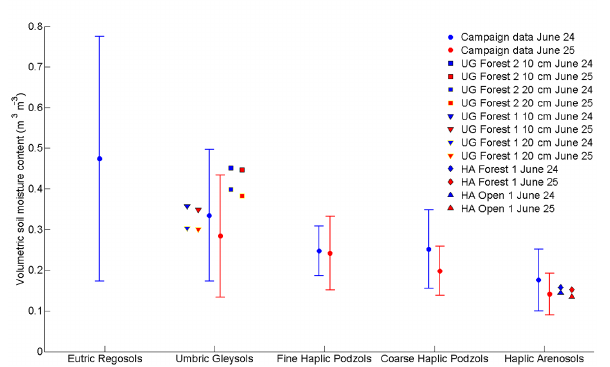
Figure 6. Comparisons of soil moisture data from the June 2014 field campaign measured with hand held Delta-T Theta Probes and from Sodankylä automatic soil moisture network stations, catego- rized by soil types. The error bars represent the range of field cam- paign soil moisture measurements, with the blue error bar indicat- ing measurements conducted on 24 June while the red error bar indicates measurements taken on 25 June. As can be observed, the automatic in situ observations on the corresponding days fall well within the average of field campaign measurements for each soil type measured. The only exception to this is UG forest 2 site data, which appears to over estimate soil moisture. Consequentially plans exist to move this site to another location.